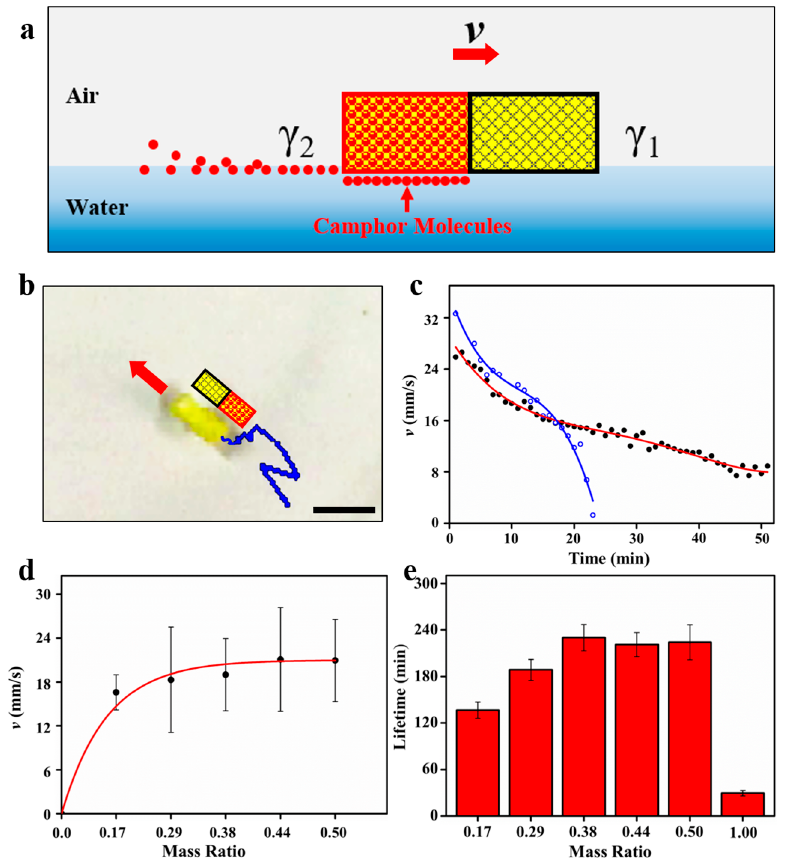
Figure 2. ( a ) Schematic illustration of the propulsion of the Janus foam motor based on Marangoni effect due to the asymmetric release of camphor. The red domain represents the camphor/SA end of the Janus foam motor. ( b ) Motion trajectory of the motor in 1 s. Scale bar: 10 mm. ( c ) The time-dependent speed ( v ) of the Janus foam motor loaded with the camphor/SA mixture ( r c = 0.38) (black dot) and pure camphor (blue circles), respectively. ( d ) The speed ( v ) of the motor versus mass ratio of camphor in the camphor/SA mixture. ( e ) Lifetime of the motor versus mass ratio of camphor.